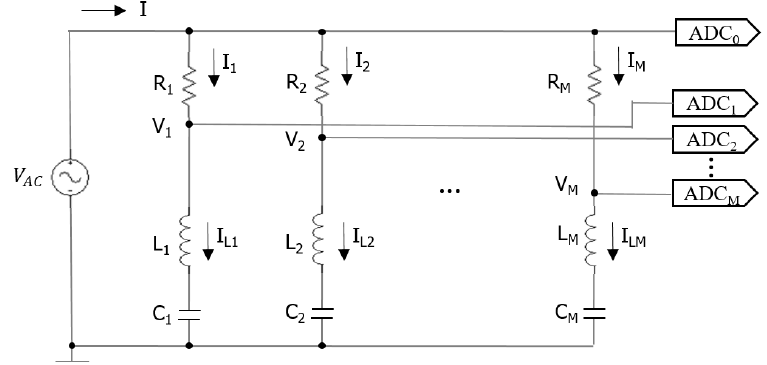
Figure 2. Equivalent metal object detection circuit.